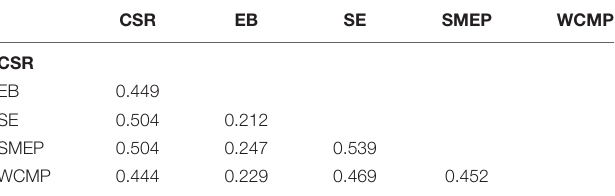
TABLE 4 | Cross-loadings. TABLE 5 | Heterotrait–monotrait